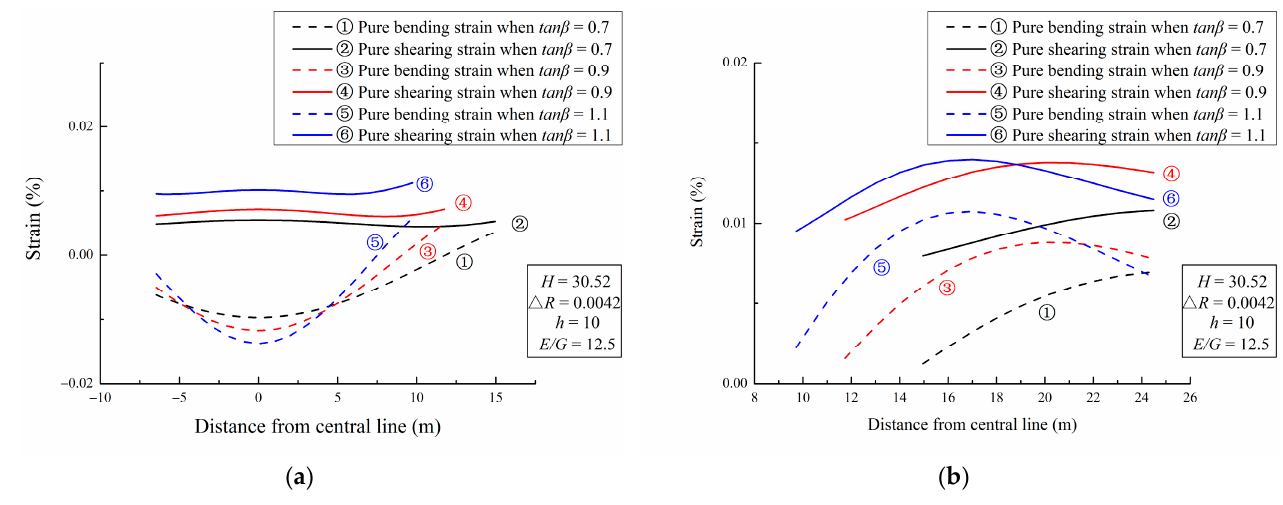
Figure 15. Effect of the tangent of the influence angle on the tensile strain in ( a ) the sagging zones and ( b ) the hogging zones.